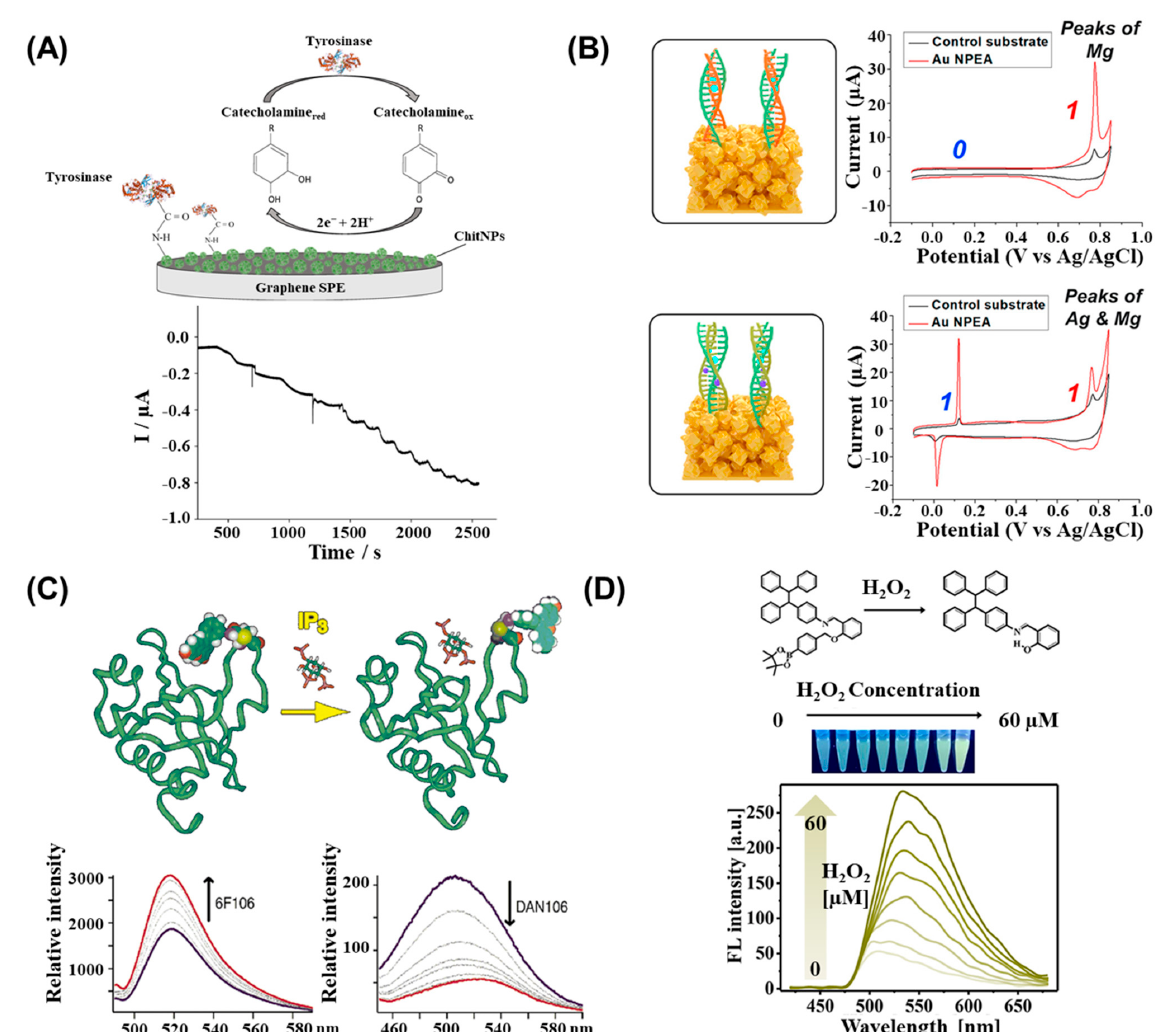
Figure 3. ( A ) Schematic image of amperometric Tyr-based biosensor on ChitNPs for catecholamine detection and its amperometric detection of catecholamine, Reprinted with permission from ref. [56]. Copyright © 2022 by the authors. Licensee MDPI, ( B ) Redox characteristics investigation of metal ions (Mg and Ag) of metal ion–nucleic acid biocomplex using CV, Reprinted with permission from ref. [58]. Copyright © 2022, American Chemical Society, ( C ) A schematic illustration of the structure of IP 3 complex (top) and Emission spectra of the fluorophore-labeled pleckstrin homology domains in phospholipase C; 6F106 domain (bottom left) and DAN106 domain (bottom right). With an increasing amount of IP 3 , the fluorophore labeled-6F106 domain showed an increase in fluorescence intensity and DAN106 domain showed a decrease in fluorescence intensity, Reprinted with permission from ref. [65]. Copyright © 2002, American Chemical Society, ( D ) Fluorescence spectra with H 2 O 2 concentrations ranging from 0 to 60 M using H 2 O 2 -triggered “turn-on” fluorescence biosensor, Reprinted with permission from ref. [68]. Copyright © 2019 by the